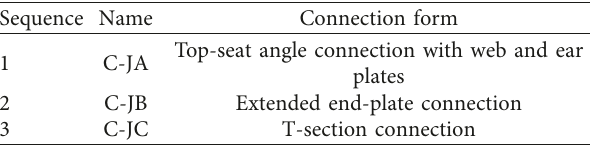
Table 2: Number of